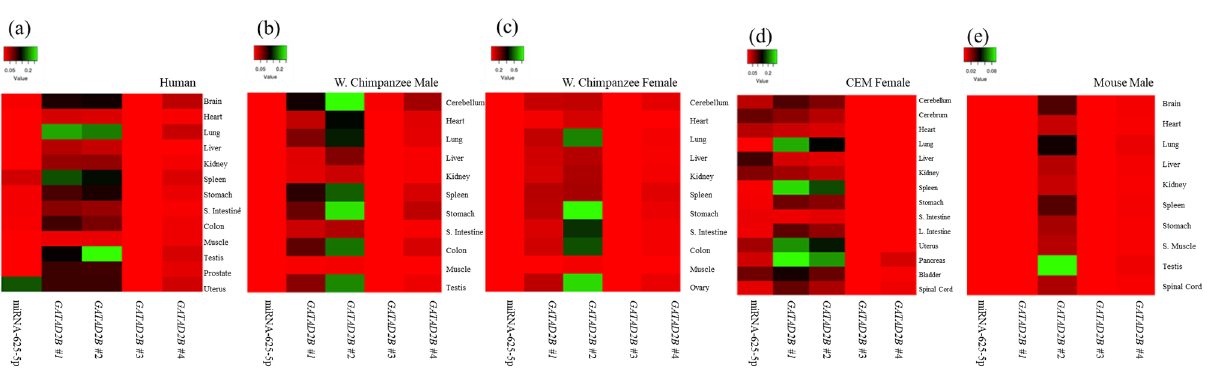
Figure 2. The relative expression analyses of hsa-miRNA-625-5p and GATAD2B by heatmap. ( a ) Heatmap of relative expression on hsa-miRNA-625-5p and 4 primers of GATAD2B in human. ( b ) Heatmap of relative expression on hsa-miRNA-625-5p and 4 primers of GATAD2B in male western chimpanzee. ( c ) Heatmap of relative expression on hsa-miRNA-625-5p and 4 primers of GATAD2B in female western chimpanzee. ( d ) Heatmap of relative expression on hsa-miRNA-625-5p and 4 primers of GATAD2B in female crab-eating monkey. Crab-eating monkey is shortened as CEM. ( e ) Heatmap of relative expression on hsa-miRNA-625-5p and 4 primers of GATAD2B in male